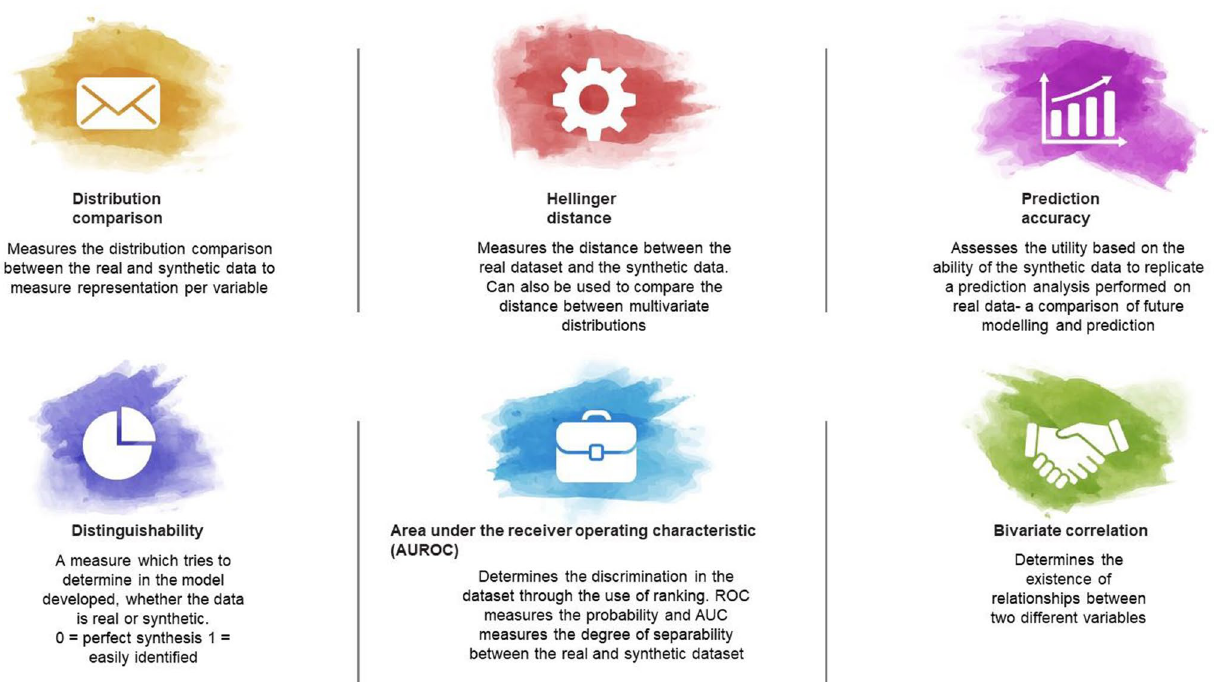
Fig. 3 Typical data quality